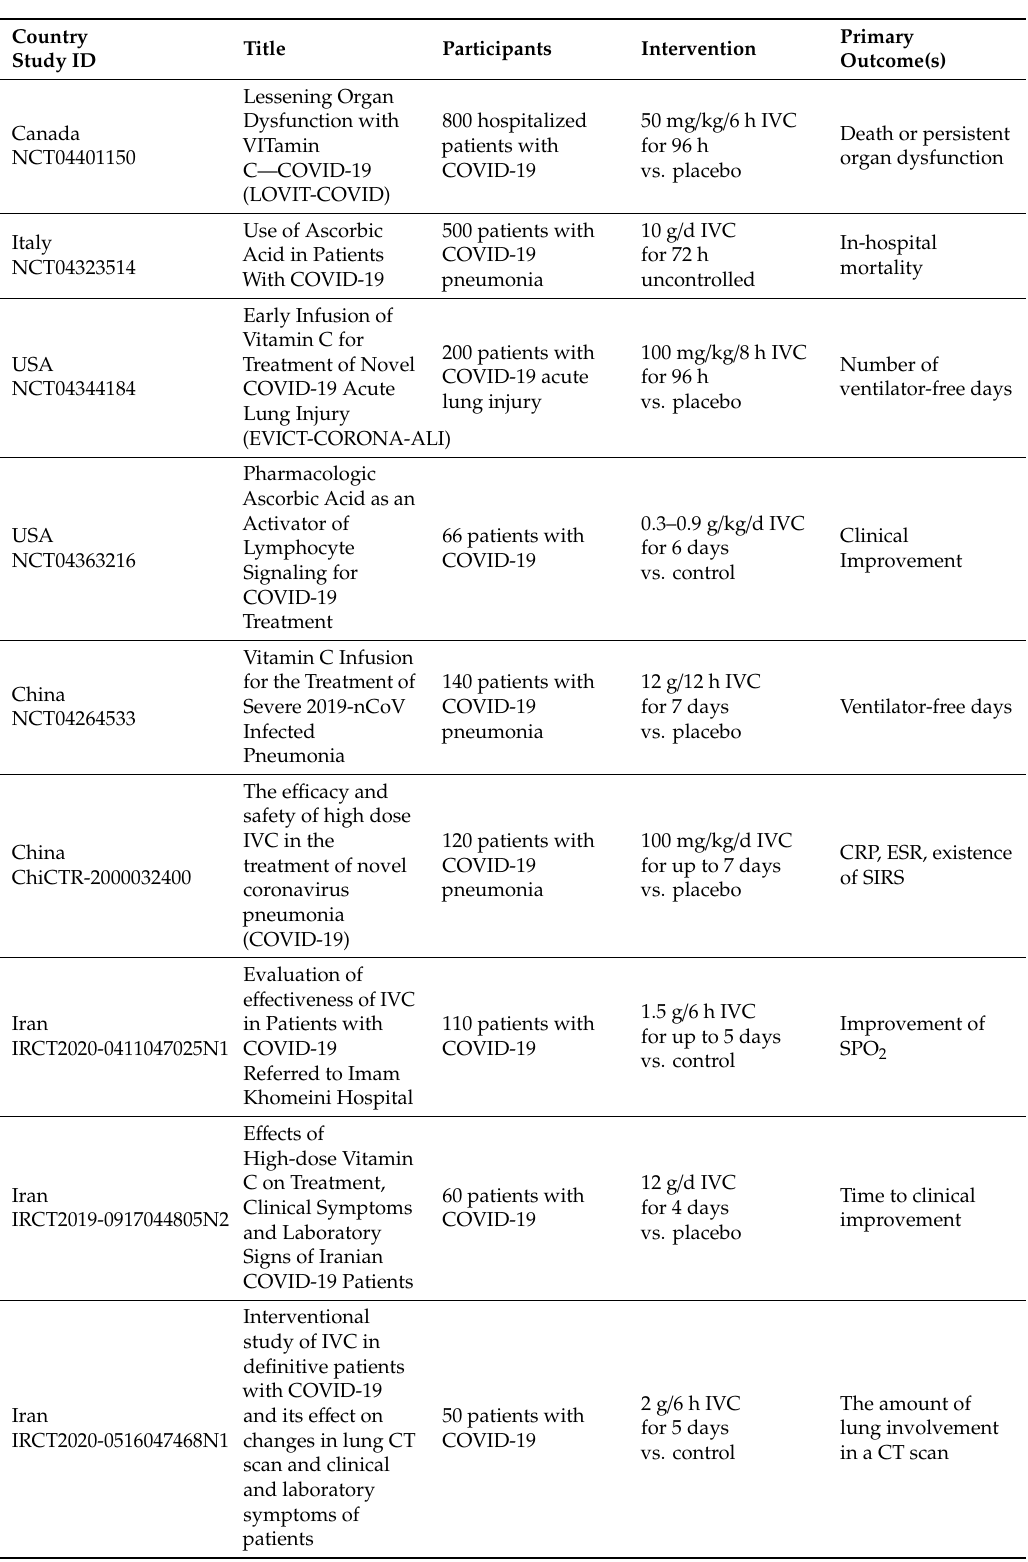
Table 1. Summary of registered intravenous vitamin C (IVC) monotherapy and COVID-19 trials